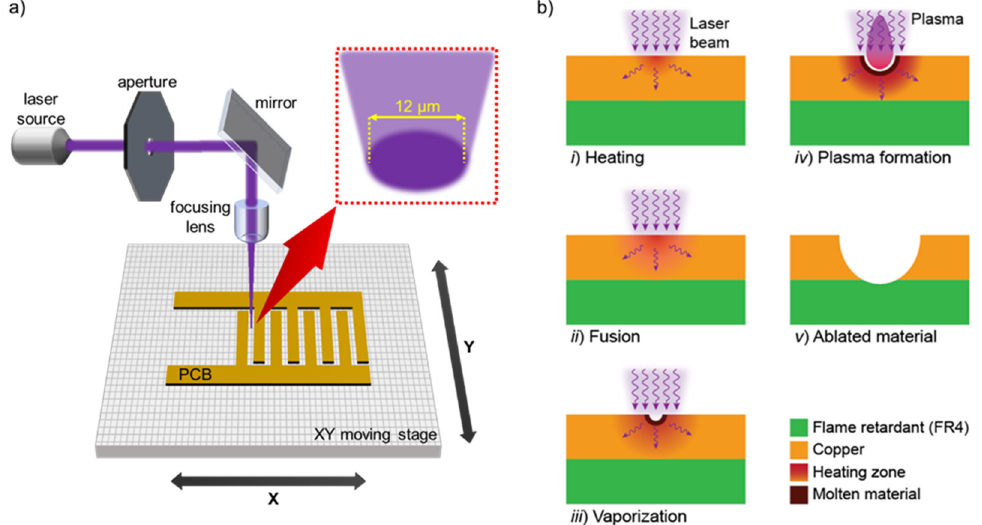
Figure 2. Conventional laser ablation process for PCB-MEMS fabrication; ( a ) schematic diagram of the optical setup and ( b ) the material removal steps by laser irradiation.